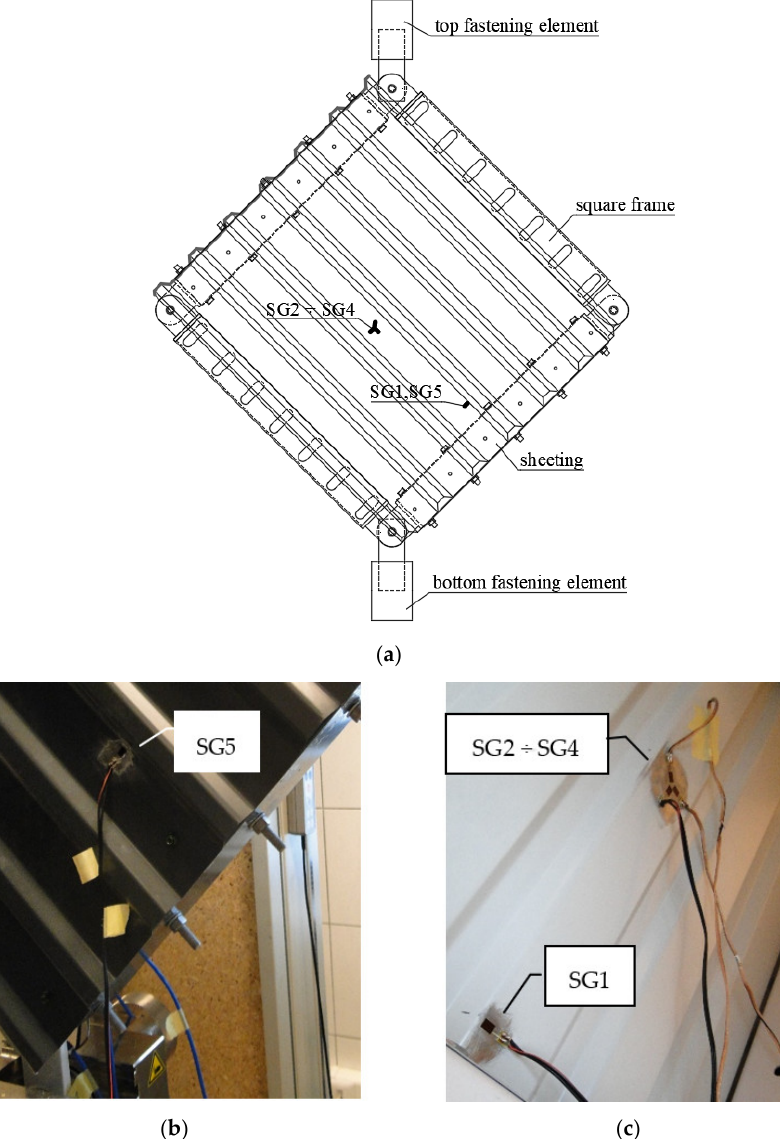
Figure 4. Strain gauge (SG) measurements: ( a ) scheme of the SG location; ( b ) SG 5 during the test; ( c ) SG 1, 2, 3 and 4 during the test. ( c ) SG 1, 2, 3 and 4 during the test.